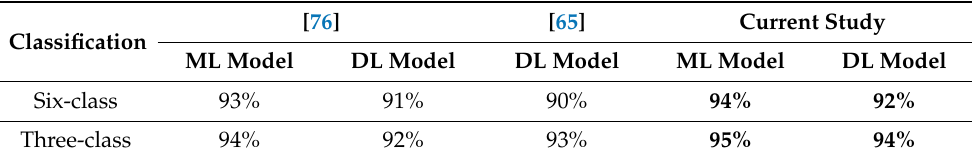
Table 10. Comparative analysis of the peer models on the flow regime dataset used in the current study comprising 11,838 data points. The accuracies are reported for individual model in each column. The best performances are highlighted in bold.